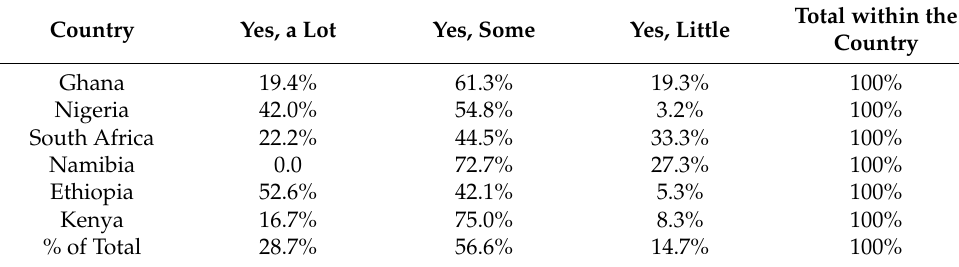
Table 4. Respondents’ understanding of climate change and human health